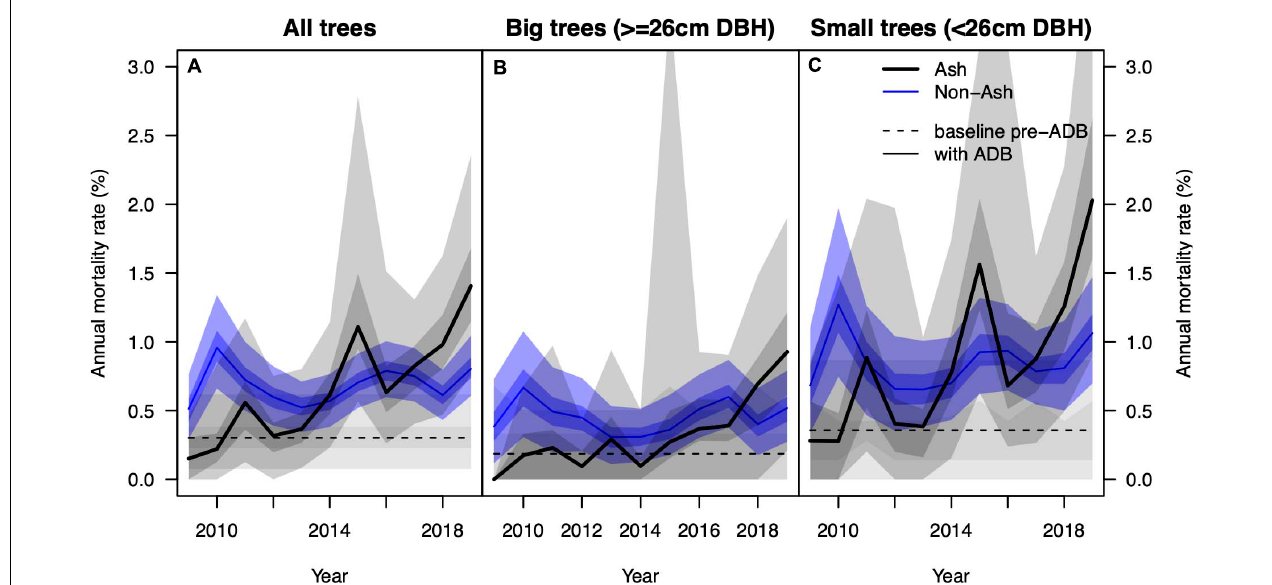
FIGURE 3 | (A) Observed annual mortality rate of ash (solid black line) and non-ash trees (blue line) based on data from the National Forest Inventory. The dashed black line denotes the annual “background” mortality rate before the arrival of the fungus. The shading around the solid lines shows the interquartile range and 95% confidence interval after 1,000 iterations of resampling with replacement. Panels (B,C) show the same information for big ( ≥ 26 cm DBH) and small trees ( < 26 cm DBH), respectively.